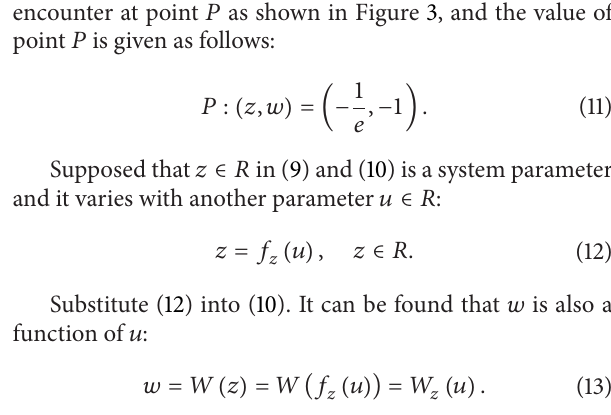
Figure 4: Curve of 𝑧 = 𝑓 𝑧 (𝑢)